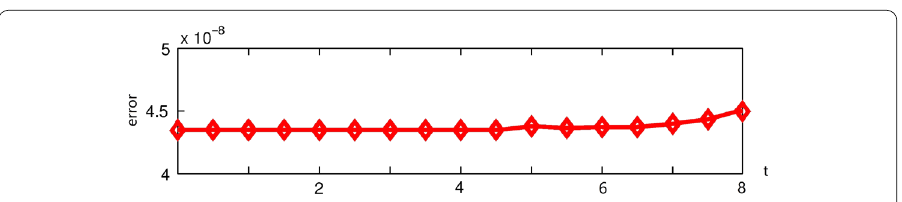
Figure 5 The SECN energy solution at t = 8